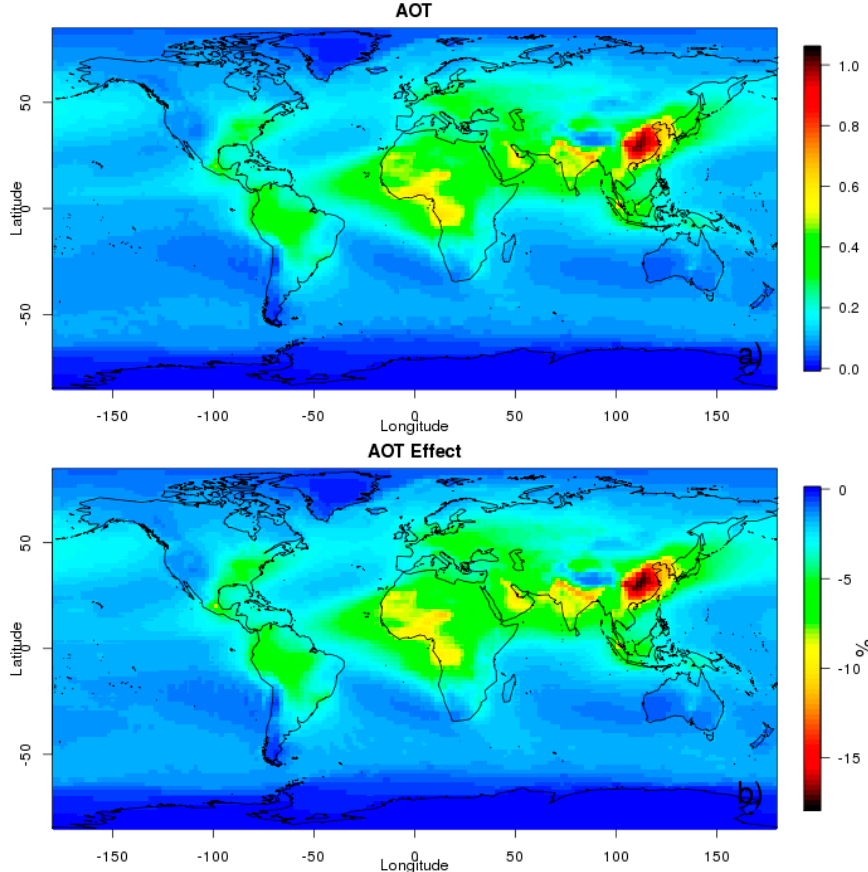
Figure 4. Global spatial distribution of averaged values of ( a ) AOT and ( b ) AOT effect during the period 2000–2019. AOT effect is quantified by Equation (2) and refers to the effects on downwelling shortwave (SW) irradiance reaching the Earth’s surface under different values of AOT.